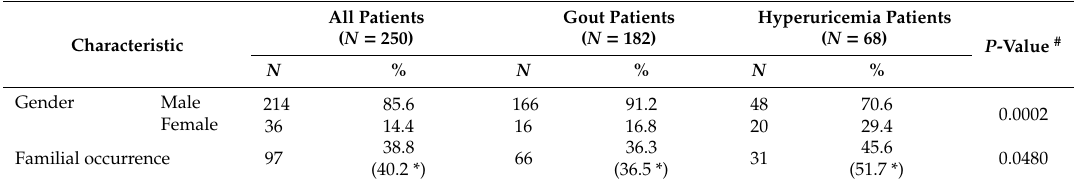
Table 1. Demographic, biochemical, and genetic characteristics of gout and hyperuricemia cohorts.